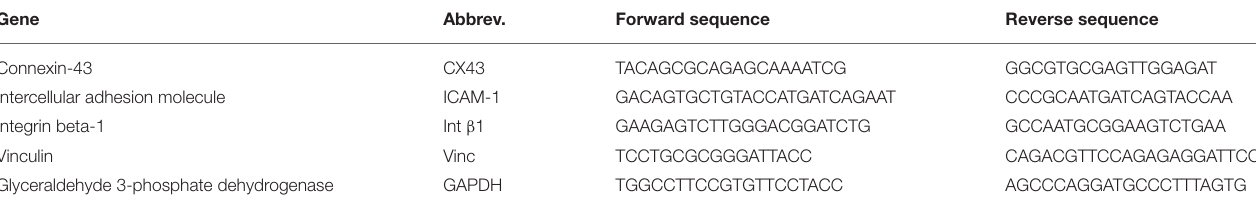
TABLE 1 | Gene sequences from PrimerExpress used for qPCR analysis. Gene